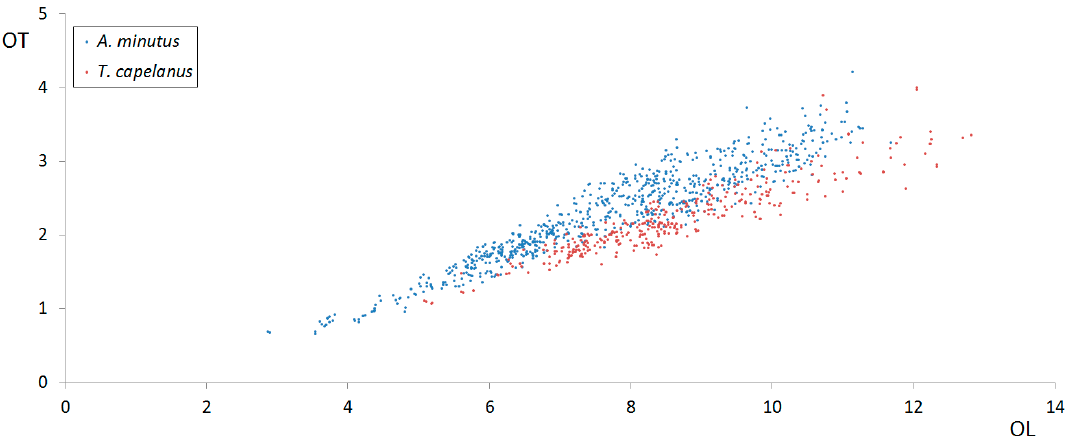
Figure 4. The ratios of otolith length (OL) and otolith height (OH) compared between Trisopterus capelanus ( n = 338) and Allotrisopterus minutus ( n = 764). OL and OH in mm.